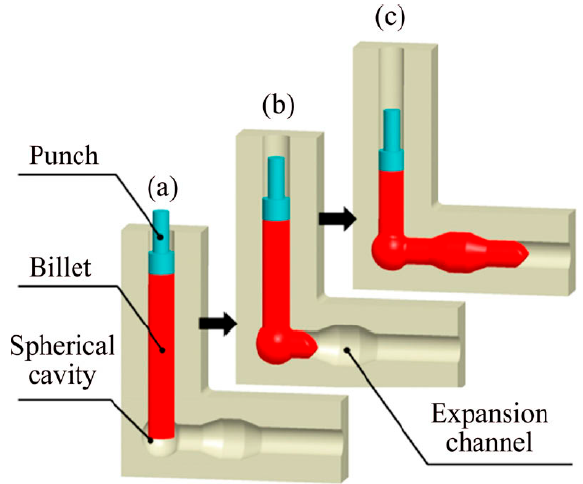
Figure 12. Schematic illustration of the ECAEE-SC method: ( a ) Channel input; ( b ) Spherical part; ( c ) Expansion channel [12].